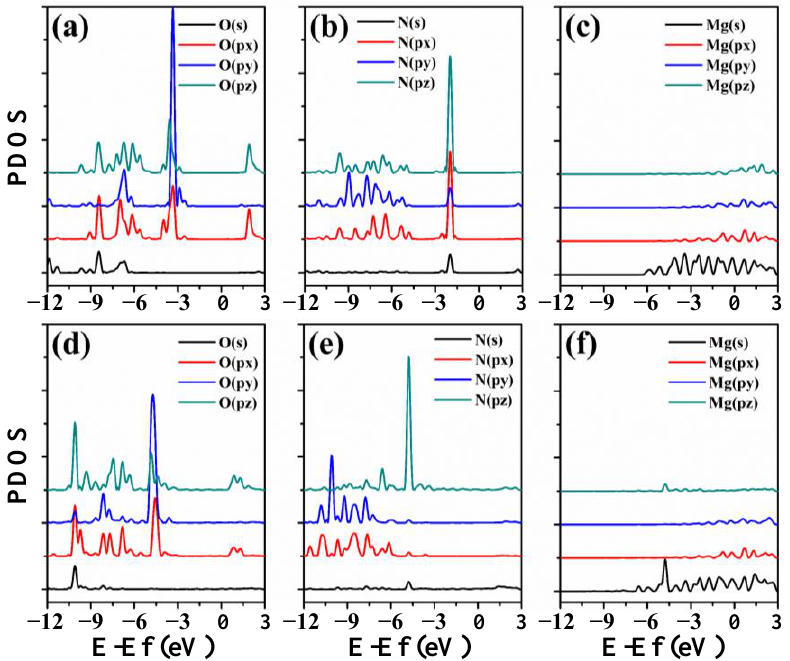
Figure 7. PDOS of the binding atoms on the Mg (1120) surface: ( a ) three O atoms, ( b ) two N atoms, and ( c ) five Mg atoms before adsorption; ( d – f ) are the PDOS of the corresponding atoms after adsorption. The energy zero is set to the Fermi level.